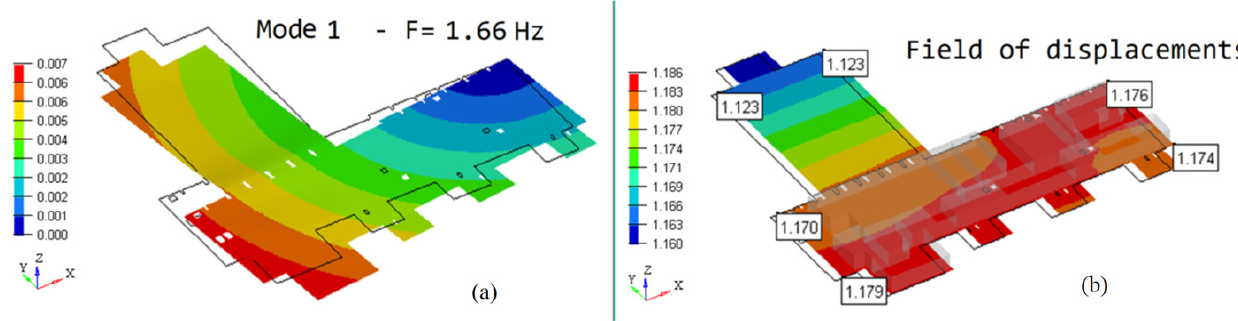
Figure 10. ( a ) Eigenmode 1; ( b ) distribution of transmissibility in different points to a harmonic excitation with the 1st eigenfrequency after the OX axis.